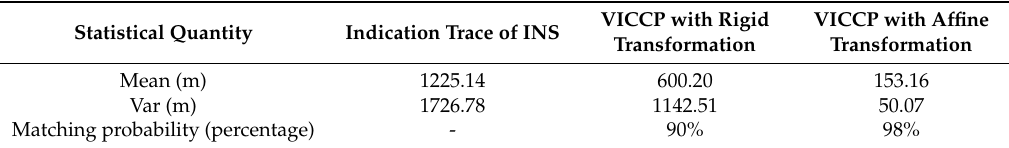
Table 4. Comparison of VICCP with different transformation for 100 times Monte Carlo